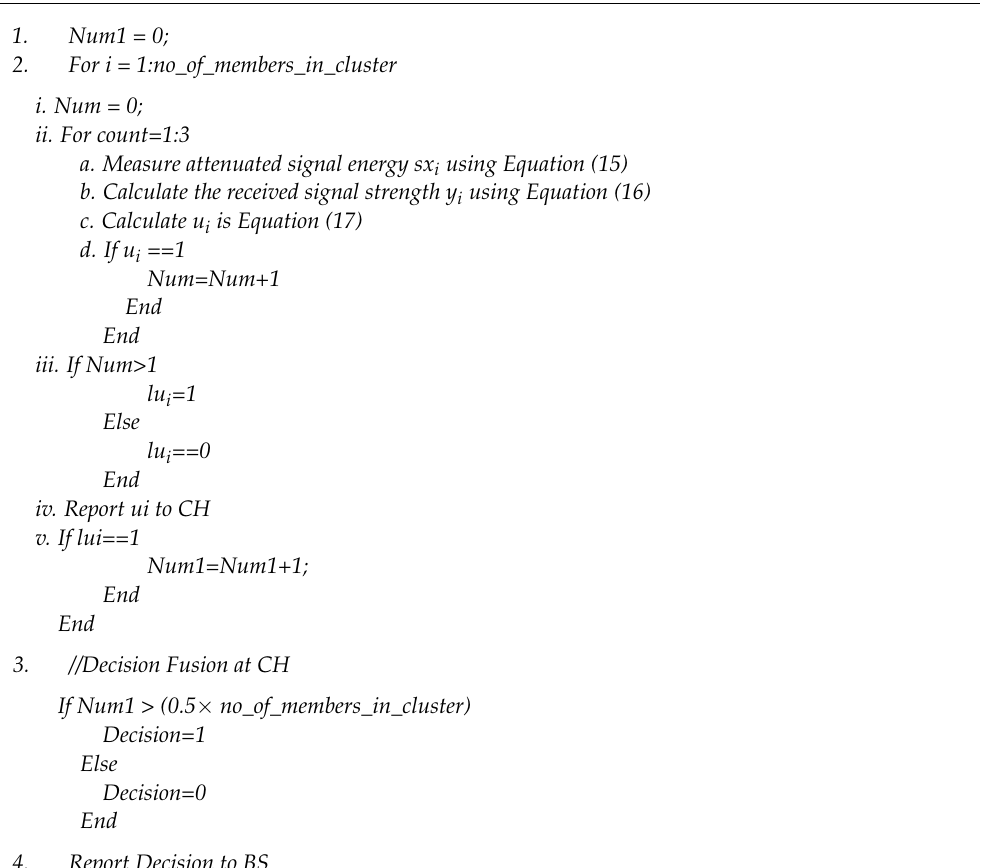
Algorithm 6 : Decision fusion